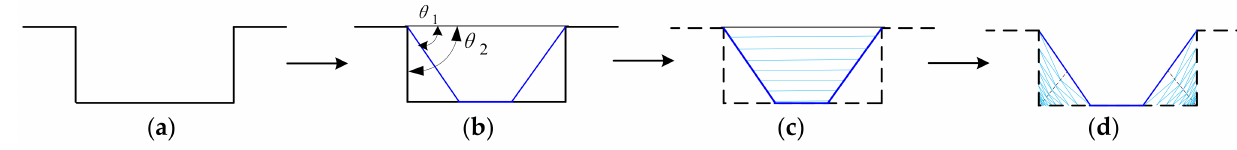
Figure 2. Forming strategies: ( a ) the straight wall part, ( b ) two stages forming strategy, ( c ) the first stage forming, and ( d ) the second-stage